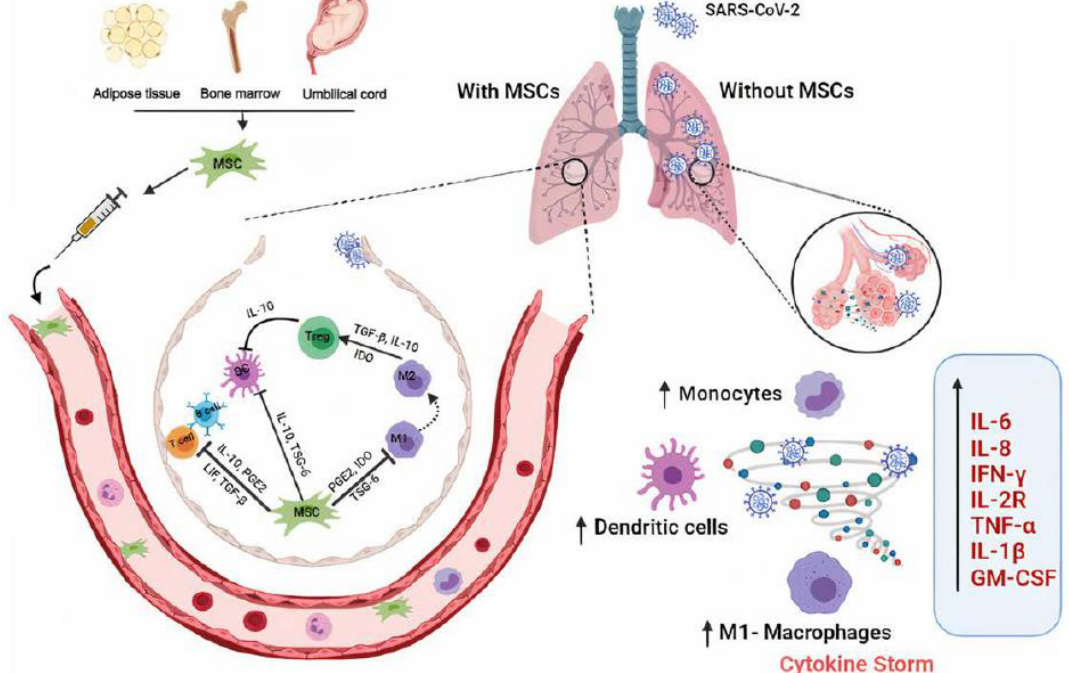
Figure 6. Schematic diagram of cytokine storm produced by SARS-CoV2 infection. Reprinted from [77]. Table 1. List of registered clinical trials using MSC-EVs. (Source: Clinicaltrials.gov; accessed on 18 March 2022).